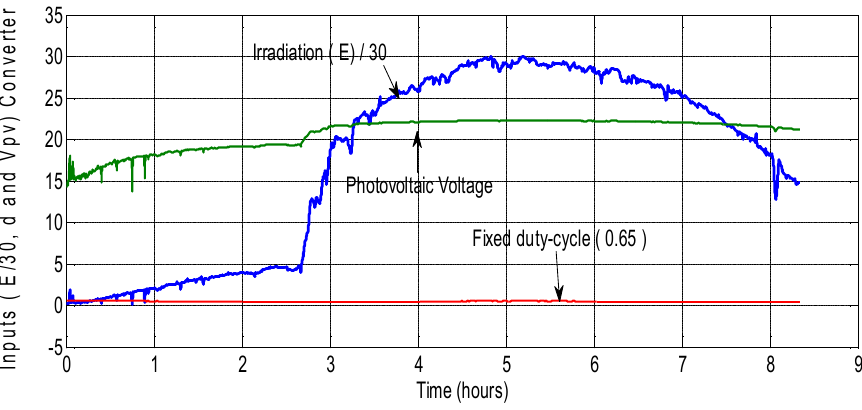
Figure 13. Inputs (d, Vpv, and E) into the converter vs. time.